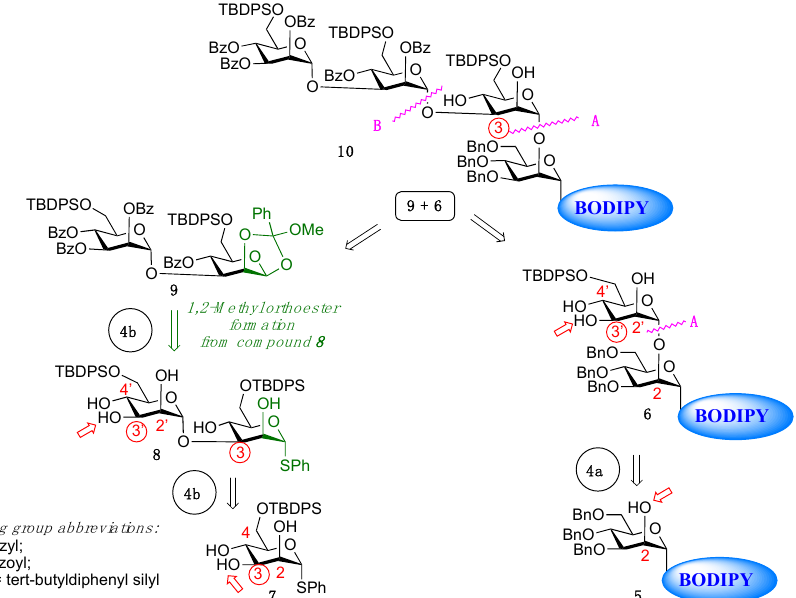
Protecting group abbreviations: Bn = benzyl; Bz = benzoyl; TBDPS = tert-butyldiphenyl silyl Scheme 1. Retrosynthesis of PI-88 tetrasaccharide analogue 10 , involving the sole use of 1,2-methyl orthoester glycosyl donors, 4 and 9